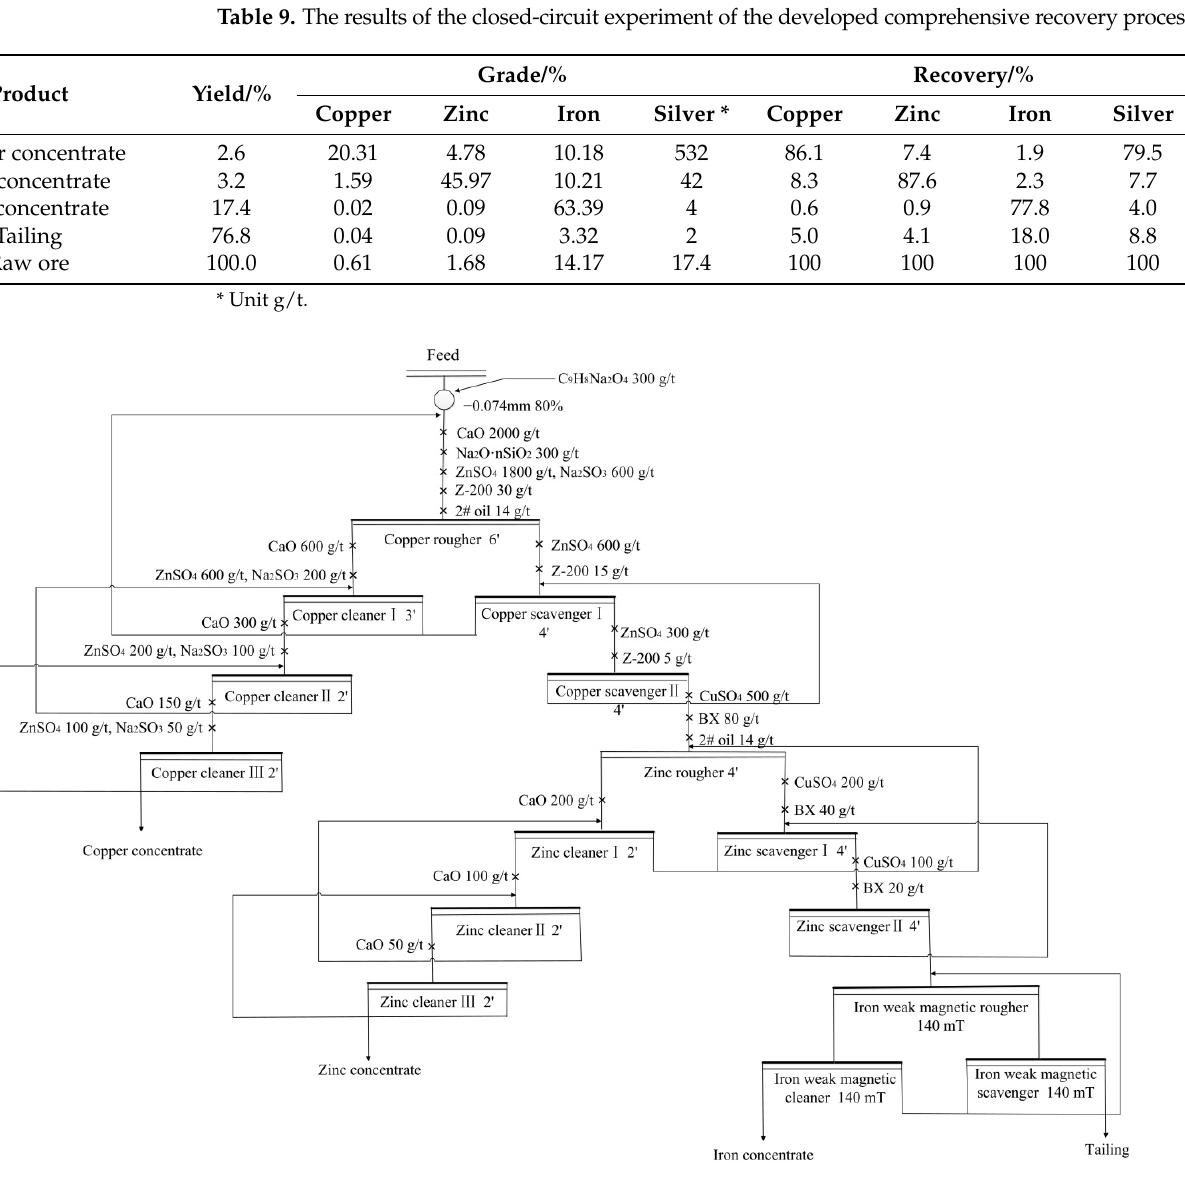
Figure 16. The flowchart of the closed-circuit experiment of the developed comprehensive recovery process. Table 9. The results of the closed-circuit experiment of the developed comprehensive recovery process.